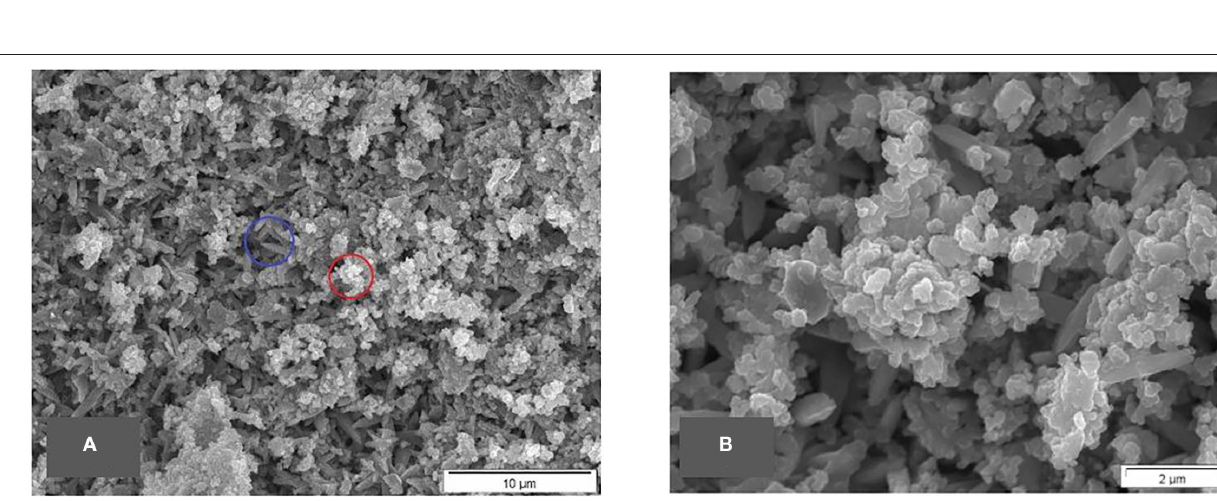
Frontiers in Public Health | www.frontiersin.org